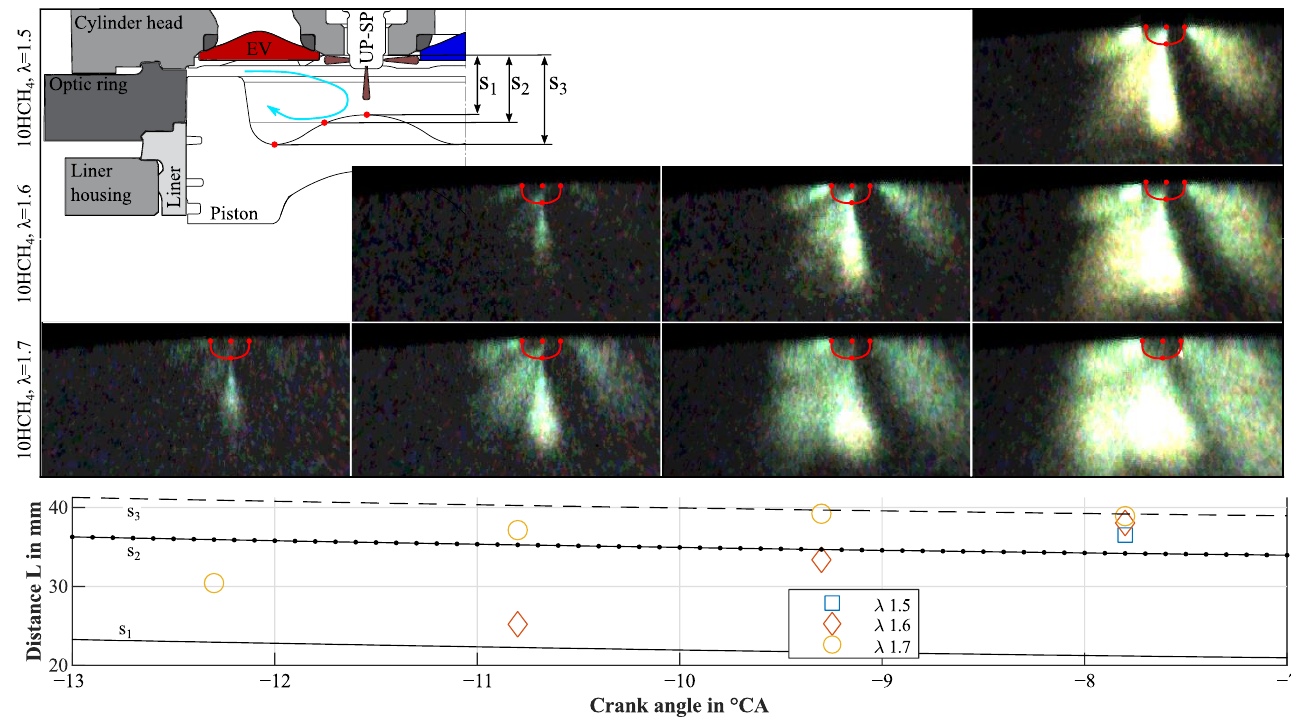
Figure 18. Torch ray images for 10HCH 4 at CoC = 8 °CA AFTDC and λ = 1.5, 1.6, 1.7. Distances s measured from the flame deck to the piston bowl.